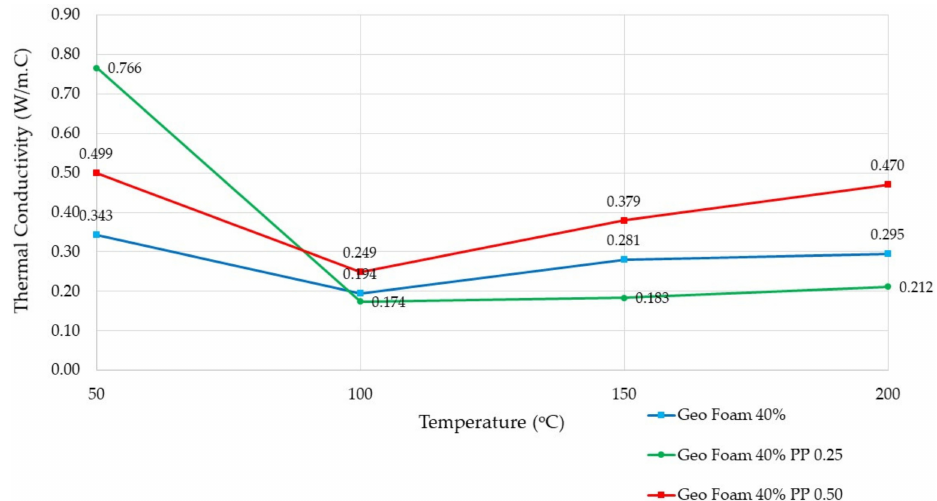
Figure 10. Thermal conductivity of 40% foamed geopolymer with varied PP fiber.